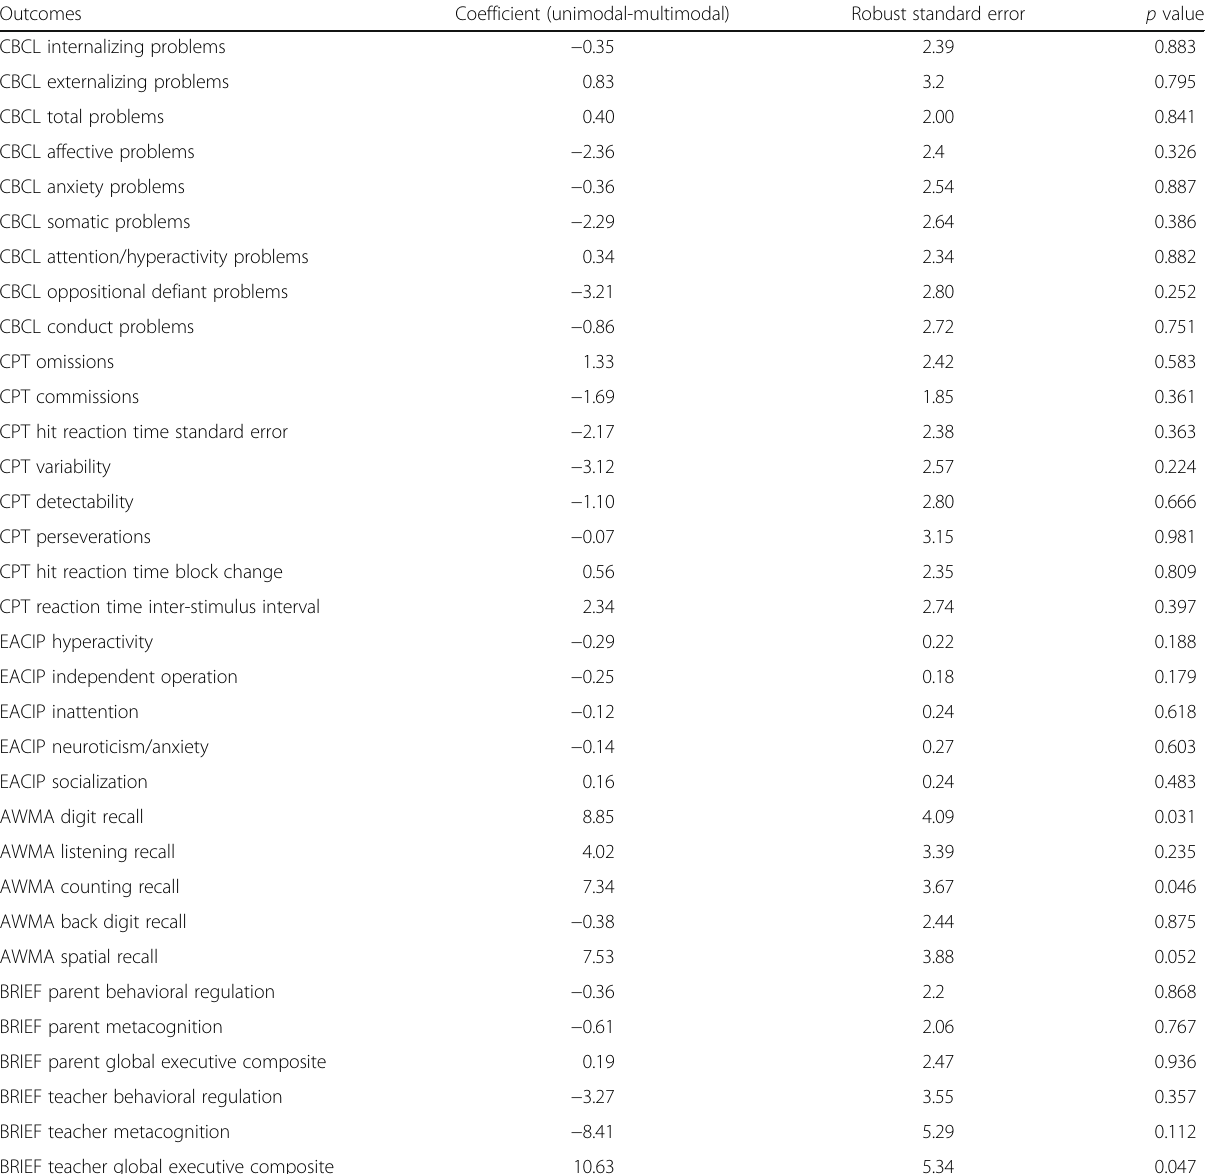
Table 4 Treatment effect using inverse probability weighted regression adjustment Outcomes Coefficient